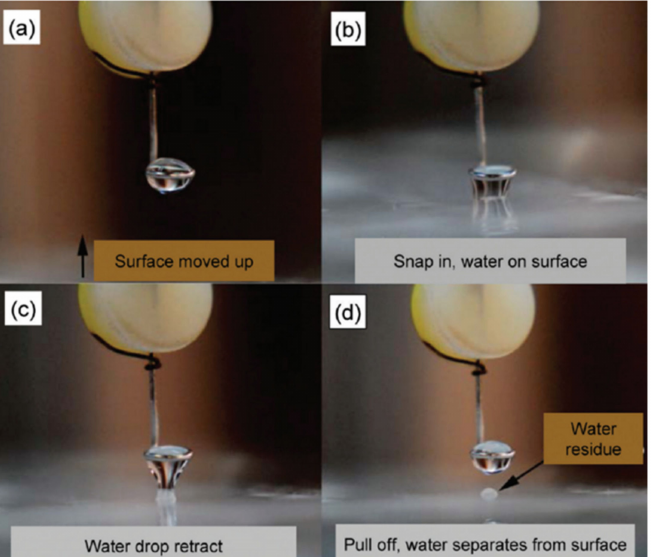
Figure 29. Optical images of the snap-in and pull-off force measurements by the microelectromechanical balance system (Reprinted with permission from [212]. Copyright {2011} American Chemical